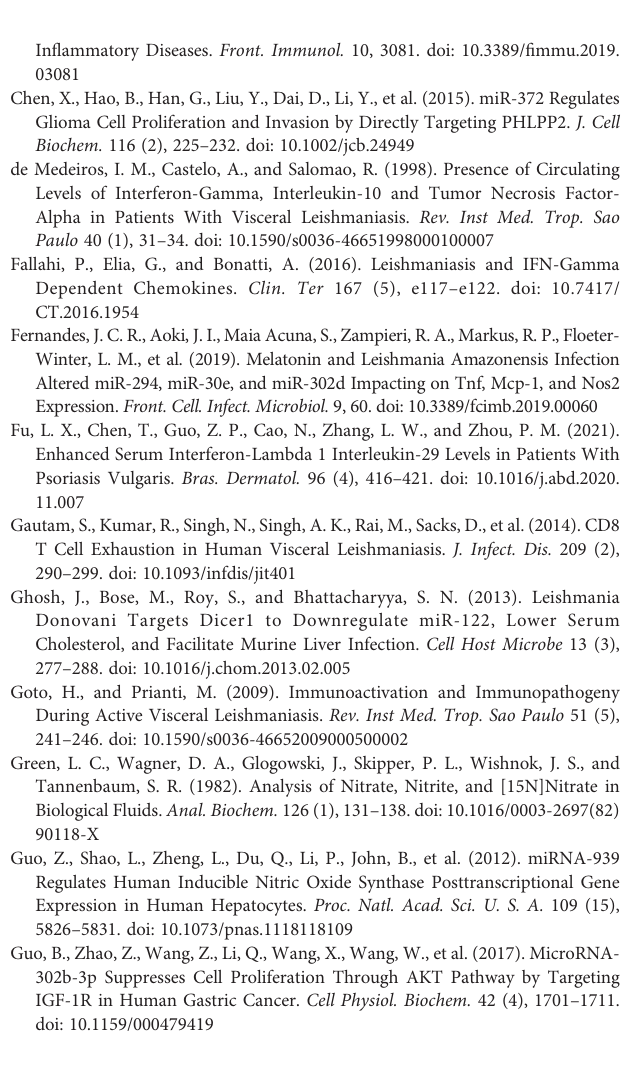
Supplementary Figure 1 | Parasite load (number of parasites/100 cells) in L. (L.) infantum promastigote-infected THP-1 cells transiently transfected with miR-548d- 3p inhibitor. THP-1 cells were transiently transfected with miR-548d-3p inhibitor (miR = 3, 10 and 30 nM) or negative control (NC - scrambled miRNA = 3, 10 and 30 nM) as described in Methods. After 24h, cells were infected with L. (L.) infantum promastigotes, and parasite load in macrophages was assessed at 6 hours